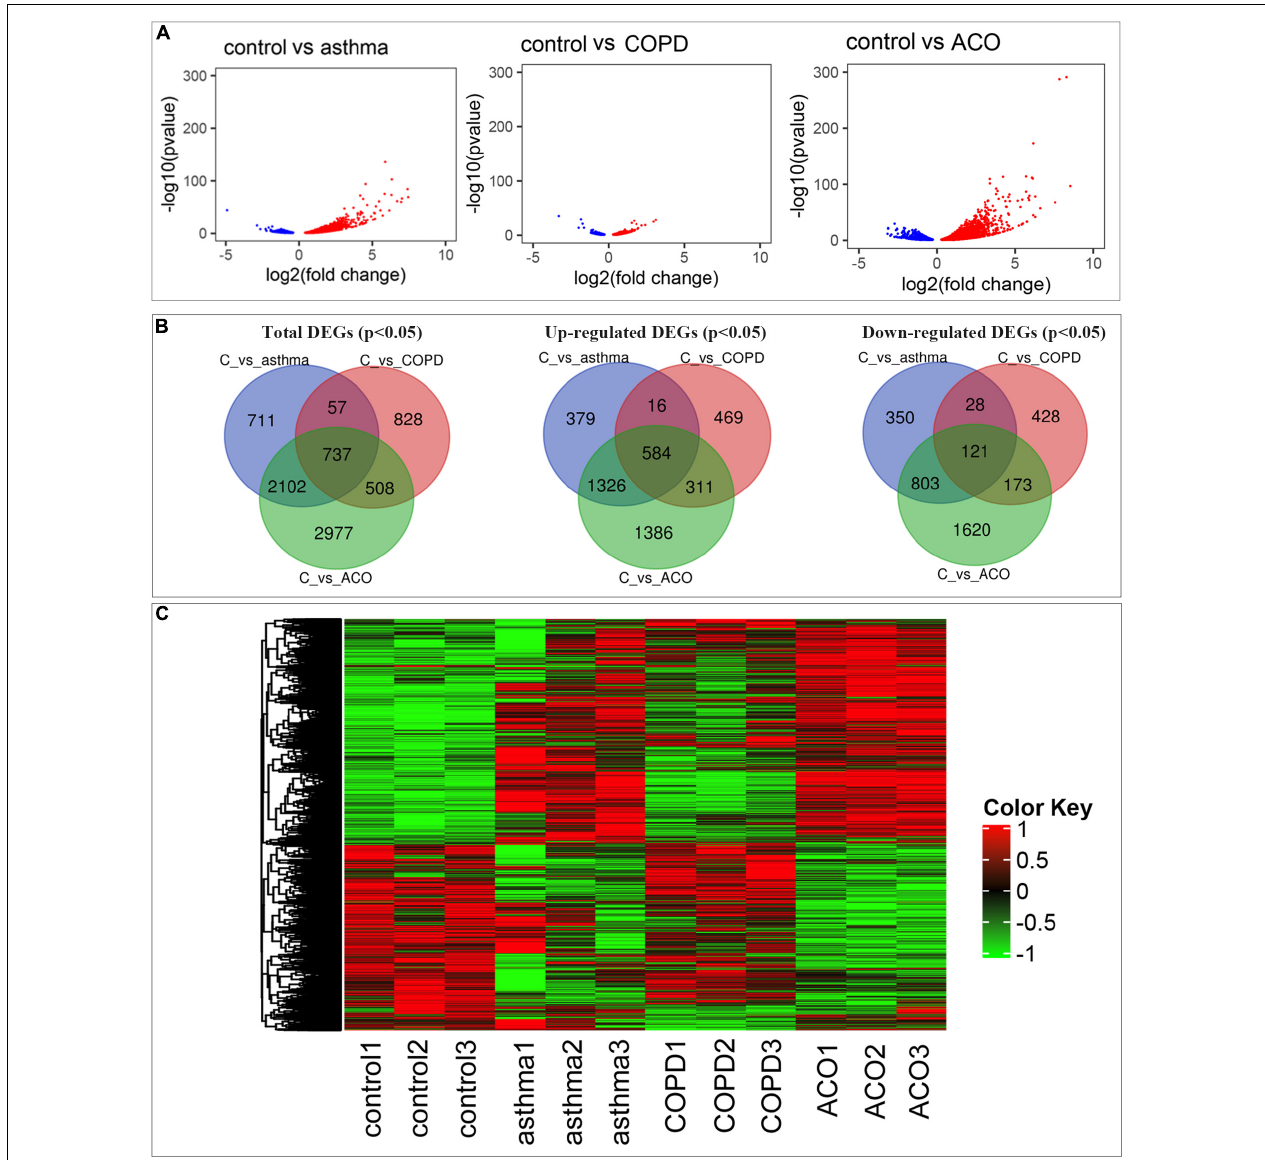
FIGURE 2 | Comprehensive analysis of differential expressed genes (DEGs). (A) comparison of DEGs in control, asthma, COPD, and ACO groups using volcano map. Red dots represent upregulated DEGs, blue dots represent downregulated DEGs, and gray dots represent non-DEGs. (B) the overlap and unique DEGs in each group using Venn diagram. (C) the expression patterns of DEGs in different groups. DEGs were identified as P < 0.05 and log2 [fold change] >